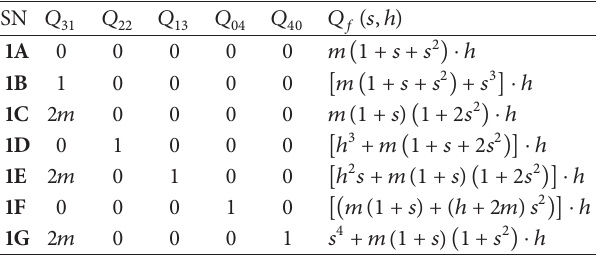
Table 1: Typical subcases of Case 1 with selected